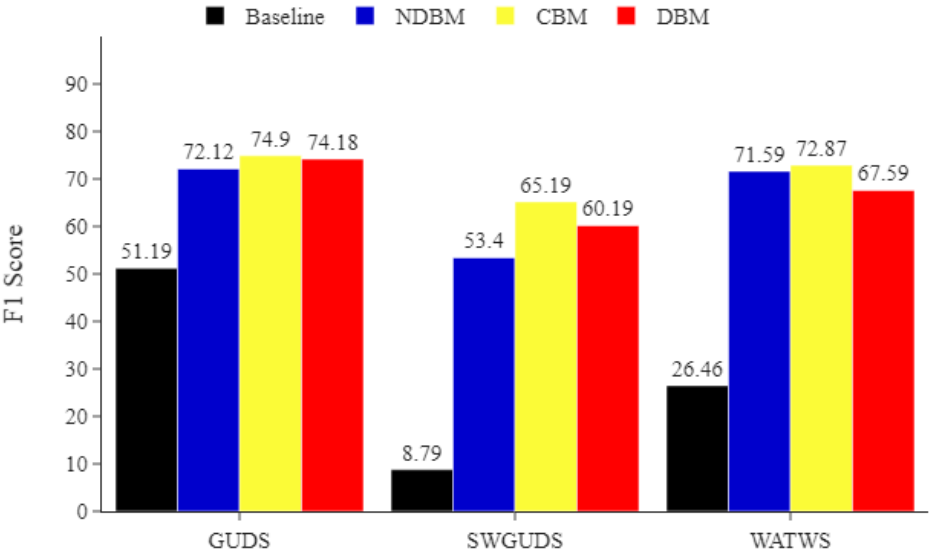
Figure 6. ADL minority classes. Comparing the impact of DBM, NDBM, and CBM on activity recognition performance, using MLP for the most underrepresented activities ( Going Up/Downstairs ( GUDS ) , Standing Up, Walking and Going Up/Downstairs ( SWGUDS ), and Walking and Talking with Someone ( WATWS )). The reported means of F 1 scores are obtained from 30 repetitions. The F 1 score is in